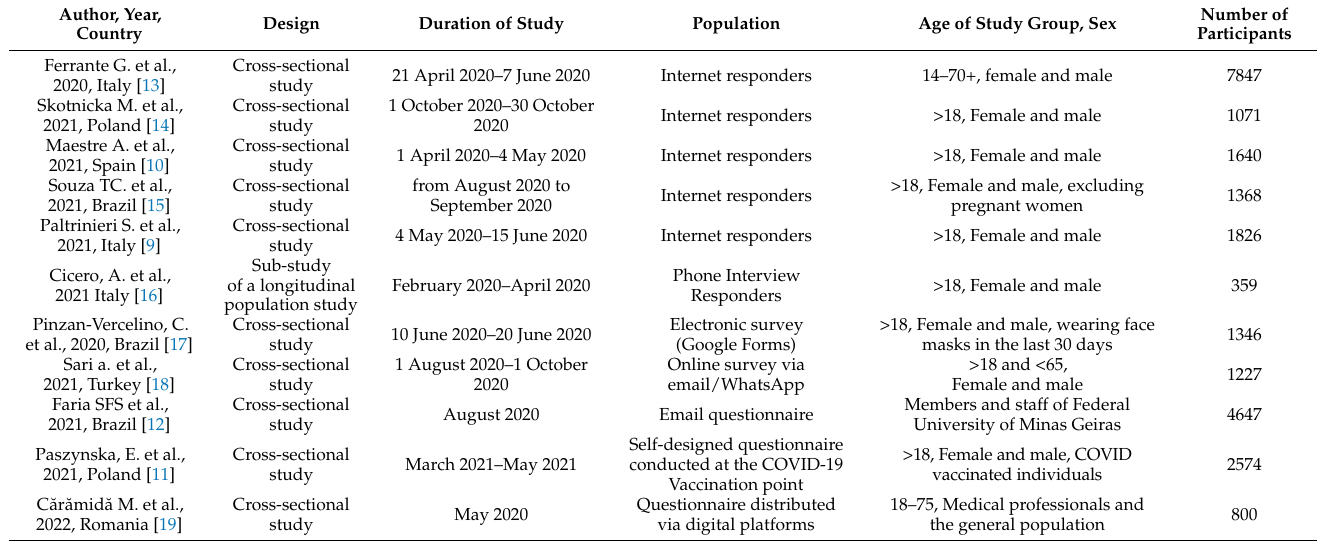
Table 3. The most important methodological characteristics of the included studies.